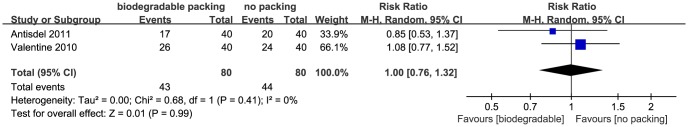
Forest plot of comparison: mucosal edema (biodegradable packings versus no packing) - for dichotomous data.